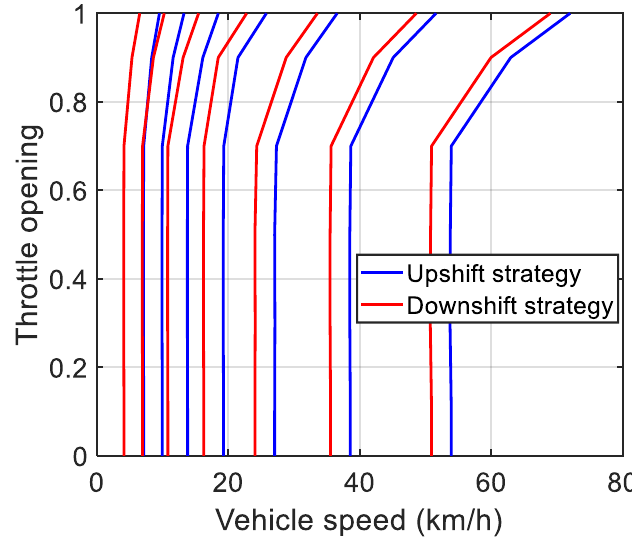
Figure 5. Shifting rule curves of SAT.